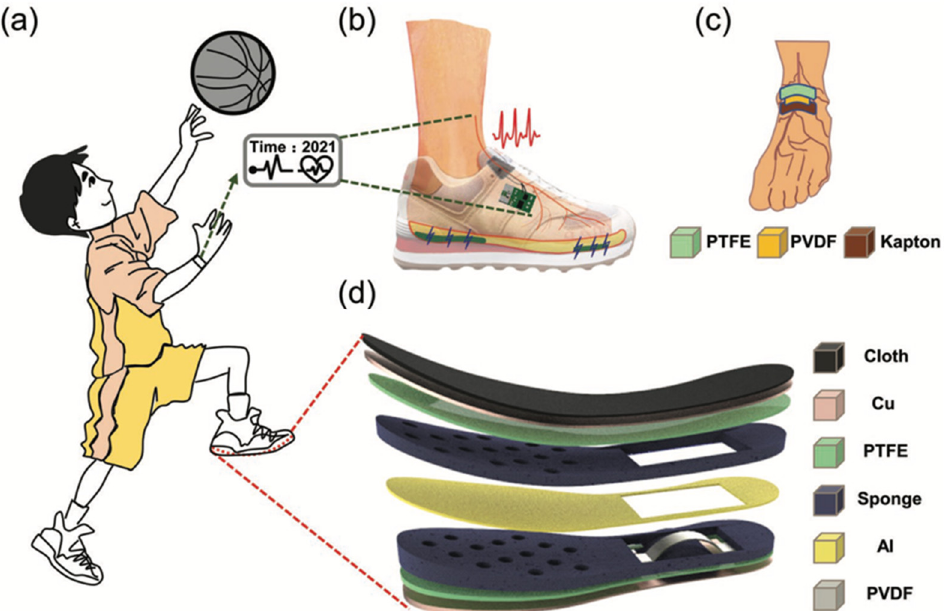
Figure 12. Schematic of the main components of the isolate hybrid nanogenerator presented by Du et al. [109]. ( a ) IHN applied to a sports shoe for monitoring the footstep types. ( b ) Schematic of the self-powered system for dorsalis pedis artery monitoring. ( c ) Schematic of the signal acquisition of the dorsalis pedis artery sensor. ( d ) Schematic of the materials and elements for the TENG and PENG modules of the IHN. Reprinted with permission from [109]. Copyright ©2022, John Wiley and Sons.